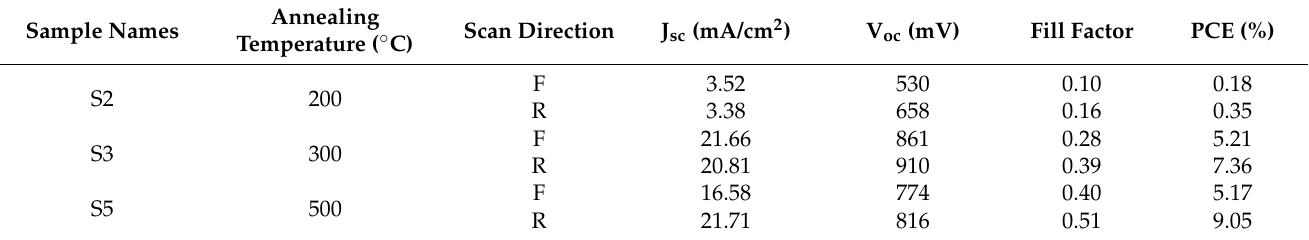
Figure 2. ( a ) The structure of the PSC fabricated here ( b ) the J-V curve of the PSCs with 160 nm-thick SnO 2 thin films, depending on annealing temperature variation. Table 1. The performance of PSCs with 160 nm-thick SnO 2 thin films, depending on annealing temperature variation.